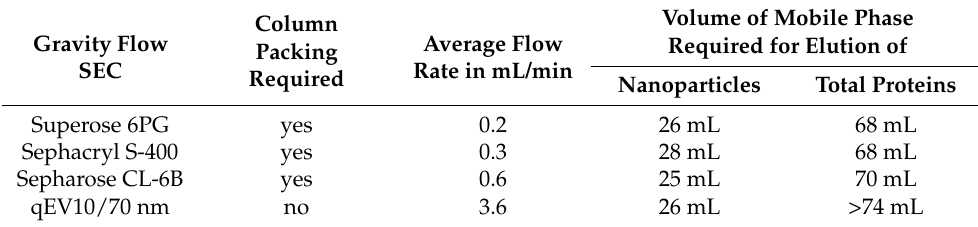
Table 2. Design and performance of four size exclusion chromatography (SEC) methods based on gravity flow and applied to separate cerebrospinal fluid from patients with severe traumatic brain injury.